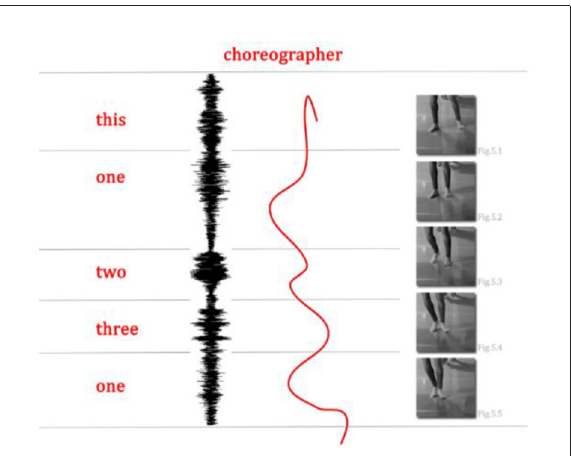
FIGURE5 Movement trajectories of CHO during the dance (line